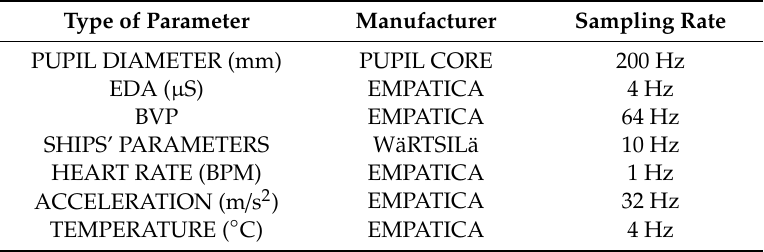
Table 4. Sensor’s sampling